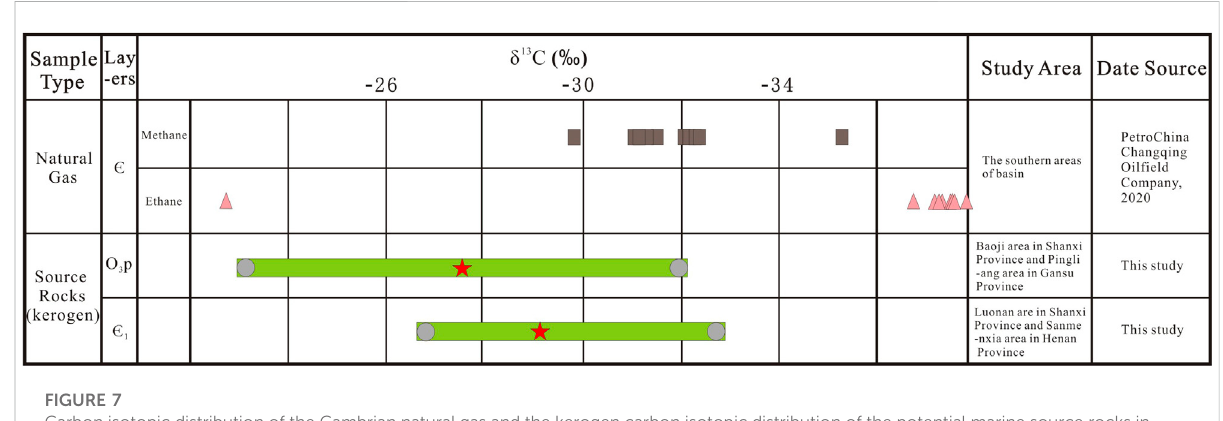
FIGURE 7 Carbon isotopic distribution of the Cambrian natural gas and the kerogen carbon isotopic distribution of the potential marine source rocks in the Ordos